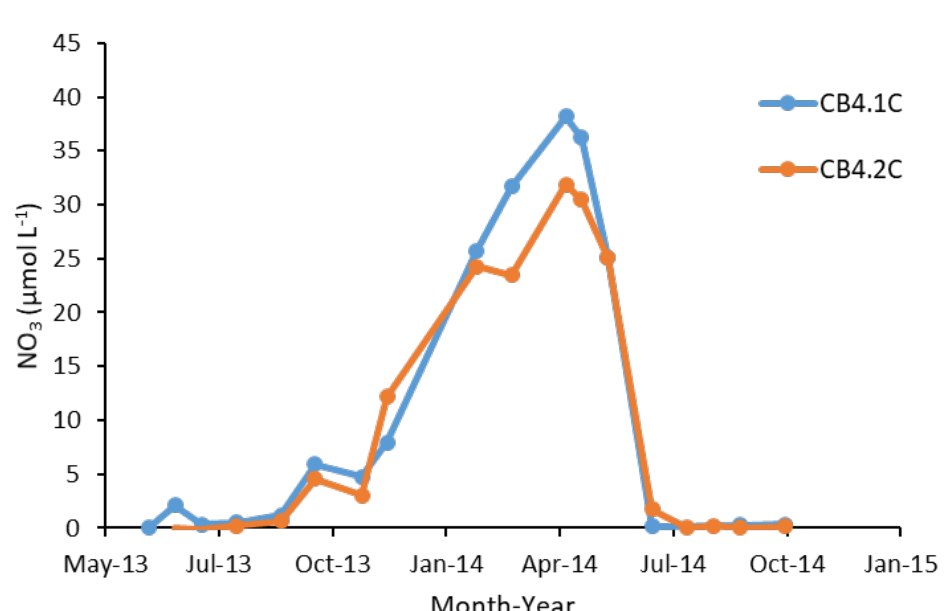
Figure 5. Main stem Chesapeake Bay surface water NO 3 concentrations from June 2013 to October 2014 [38]. Sites CB4.1C and CB4.2C are located approximately 5 km north and 15 km south of Poplar Island, respectively.